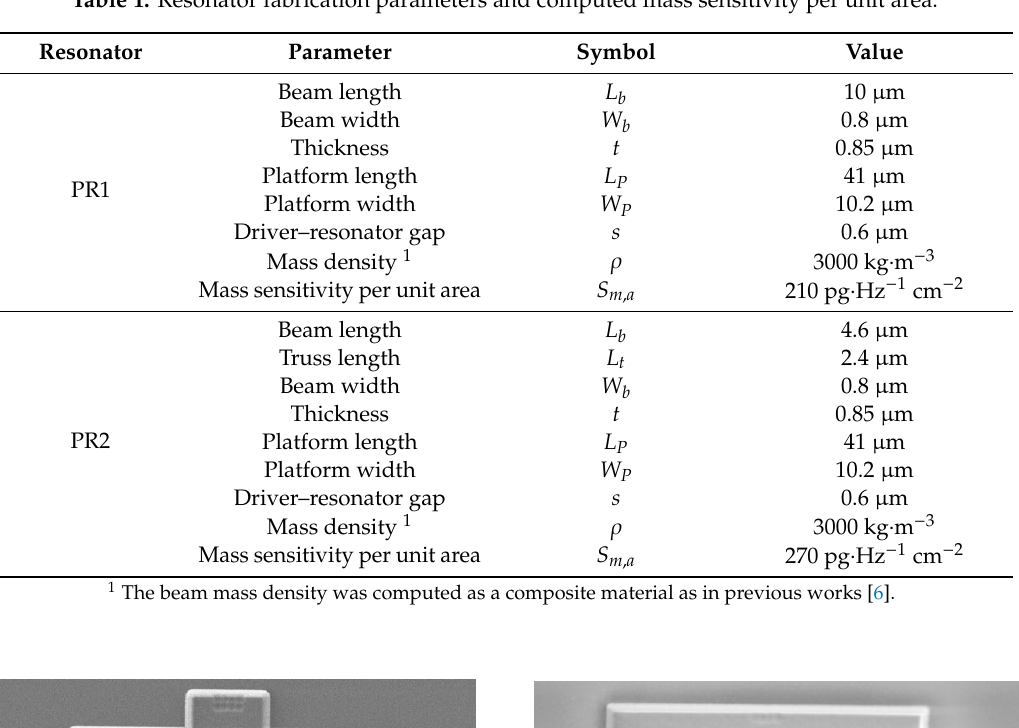
Table 1. Resonator fabrication parameters and computed mass sensitivity per unit area.